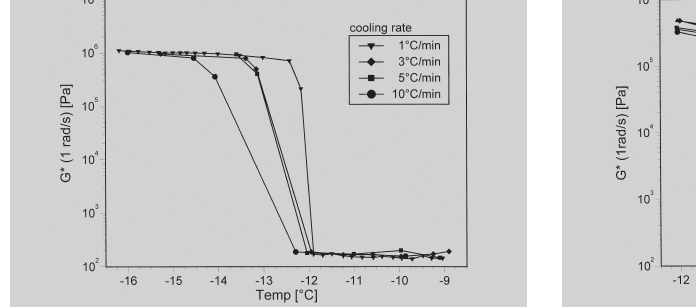
Figure 3 (left): Rheological cooling curves for o/w emulsion A at different cooling rates. Figure 4: Rheological cooling curves for o/w emulsion B with varying plate gap.